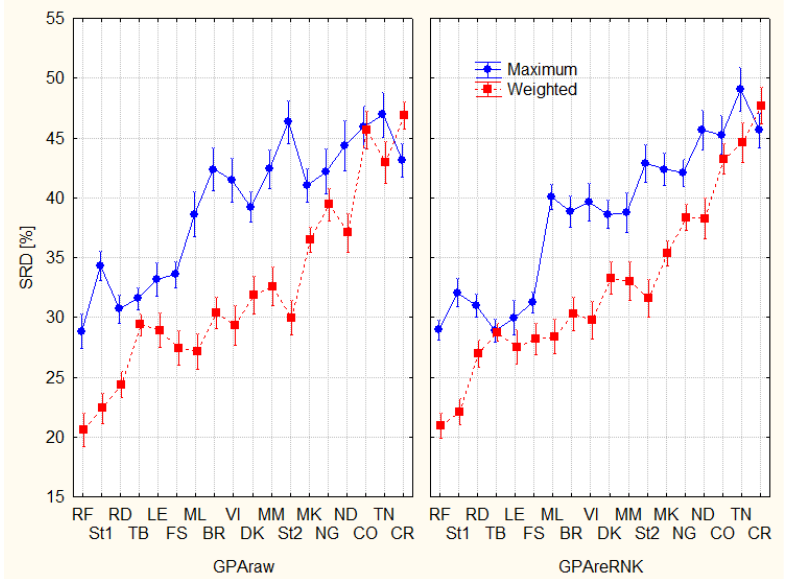
Figure 5. Splitting of experts according to ranking options (F1*F2); Sum of Ranking Differences, SRDs are scaled between 0 and 100. The error bars represent 95% confidence interval. F1: GPAraw–original GPA coding, GPAreRank (recoding to full rank), F2: Maximum, Weighted.